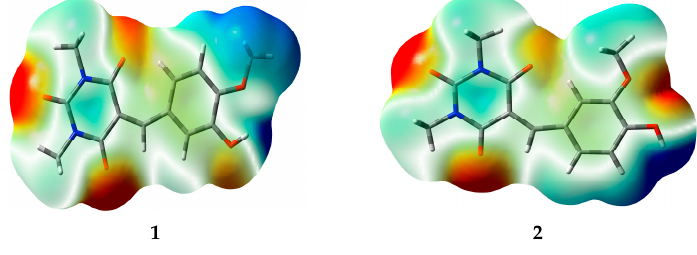
Figure 6. Electrostatic potential (ESP) maps of 1 and 2 .